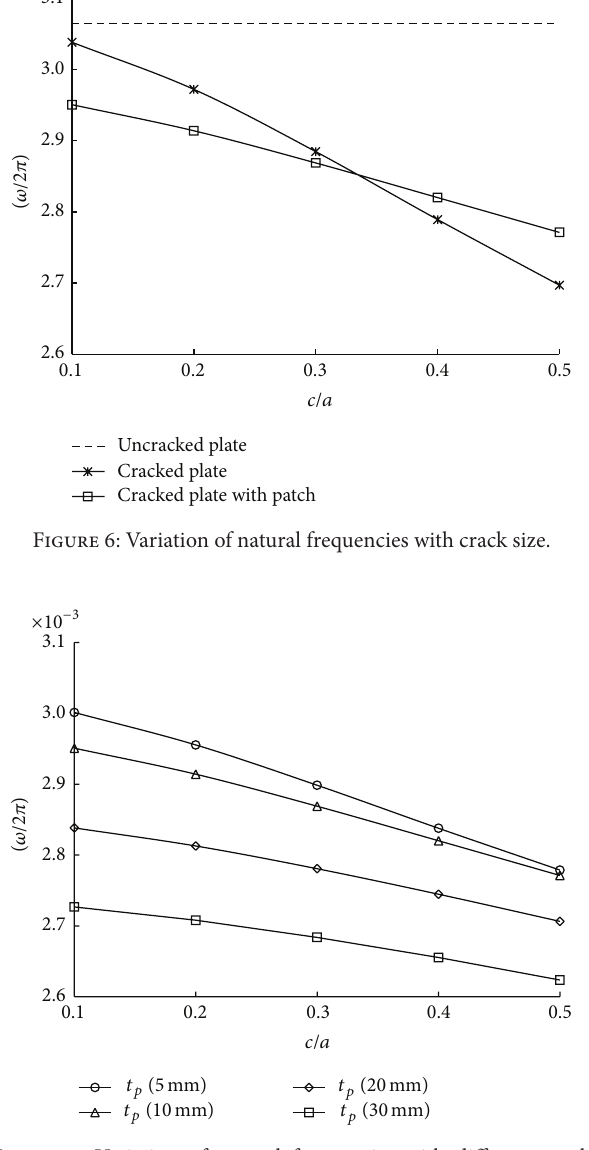
Figure 7: Variation of natural frequencies with different patch thickness.